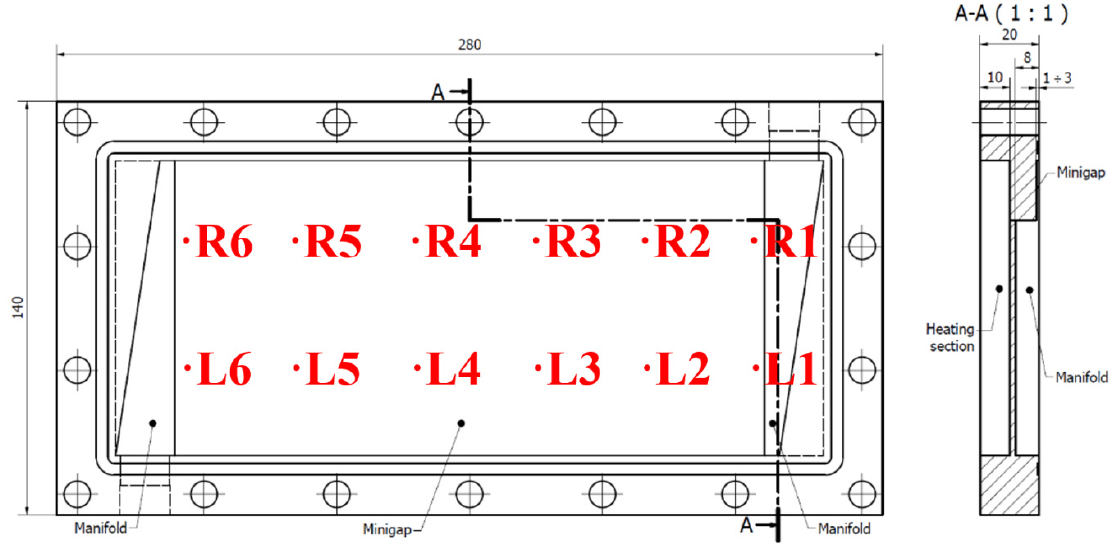
Figure 2. Schematic view of the test section—minigap heat exchanger: L1–L6—left temperature measurement points in the wall; R1–R6—right temperature measurement points in the wall.